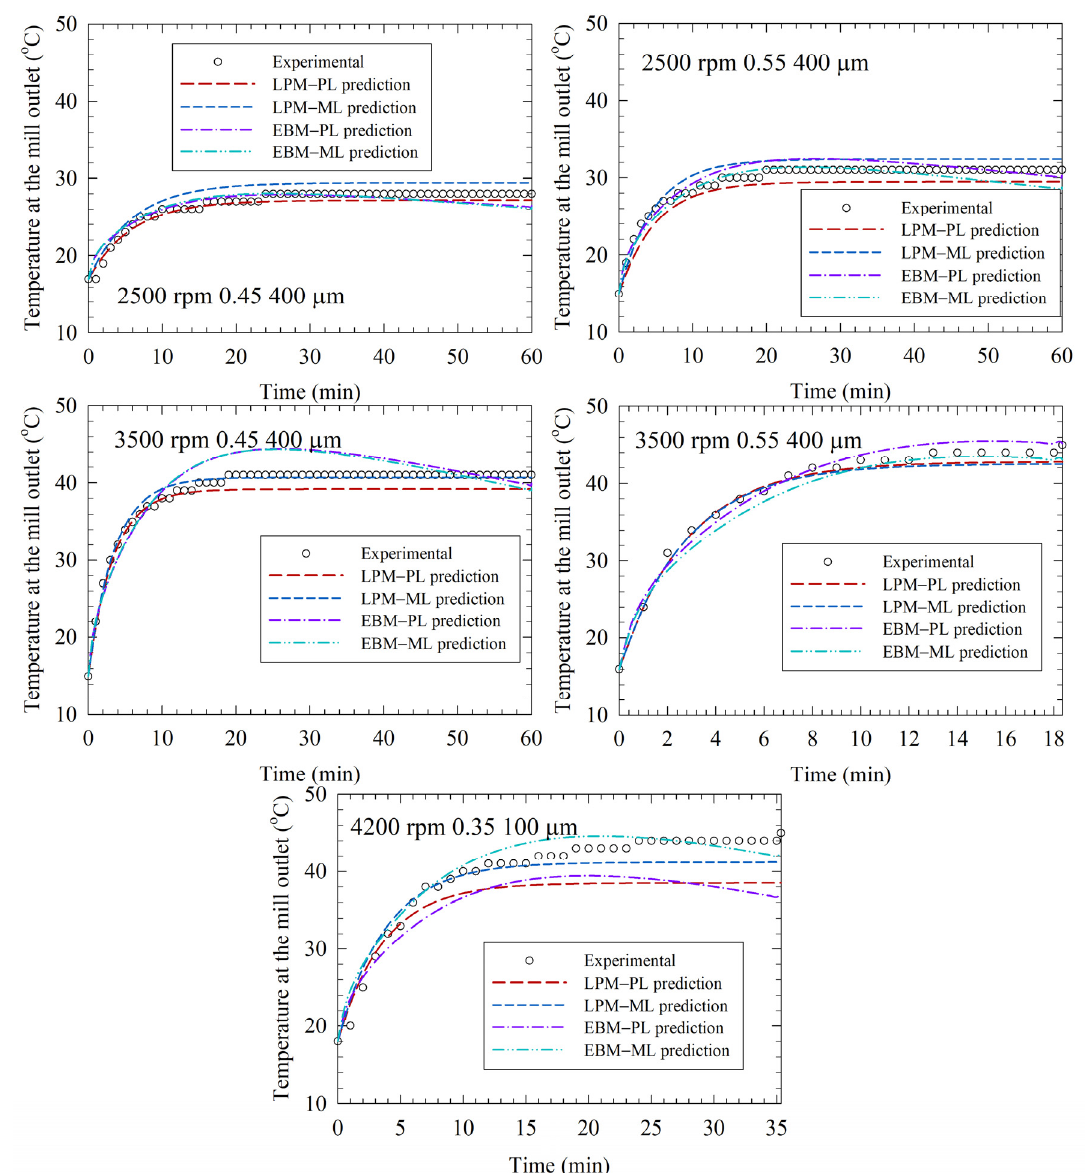
Figure 7. Predictions by power law (PL) and machine learning (ML) models coupled with the lumped parameter model (LPM) and the enthalpy balance model (EBM) for the test runs (Runs 28–32). The EBM predictions were taken from Guner et al. (2022) [33].